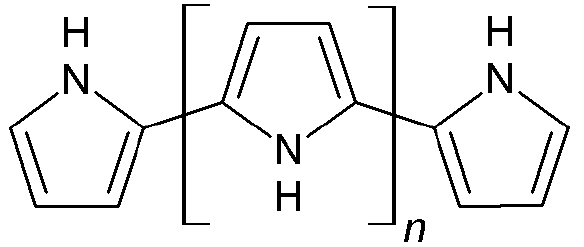
Figure 1. The formula of pyrrole oligomer. n = 0, 1, 2, ...